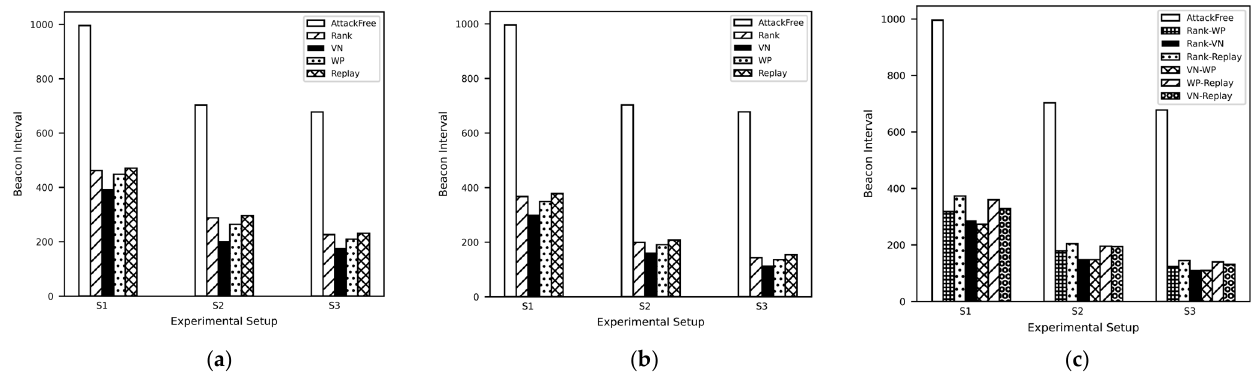
Figure 4. PPC Rate Results: ( a ) Single-Attack Scenario; ( b ) Composite-Attack Scenario; ( c ) Hybrid- Attack Scenario.